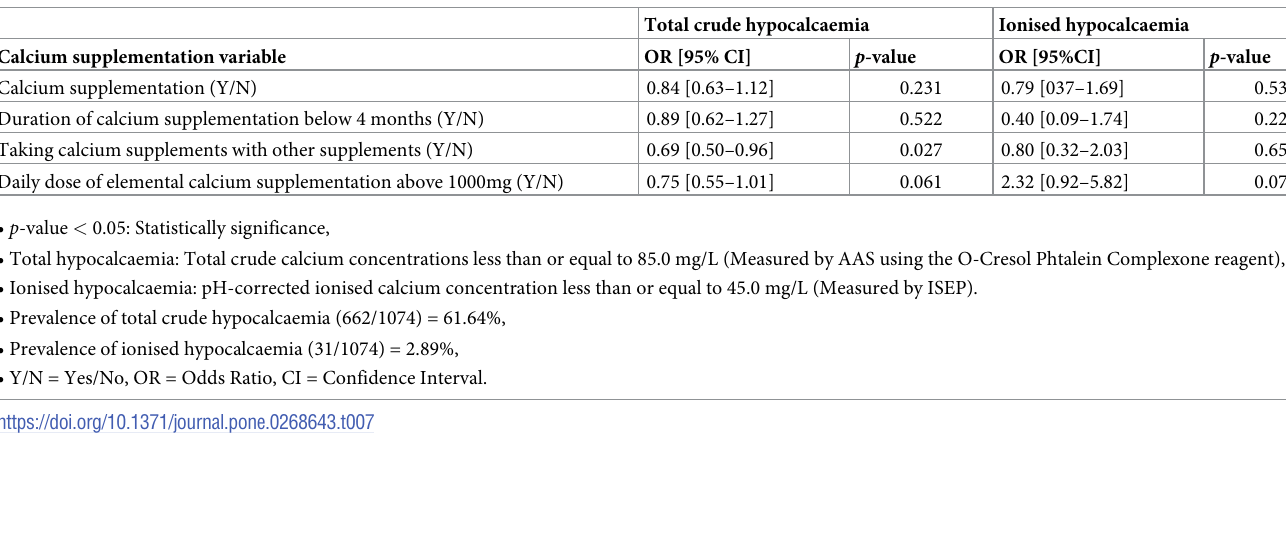
Table 7 evaluates calcium supplementation as a factor influencing calcaemic states. From the table, calcium supplemented women had respectively, 0.84 and 0.79 lower odds of total ( p -value = 0.231) and ionised hypocalcaemia ( p -value = 0.538) compared with non-supple- mented women. Also, taking calcium supplements at the same time as other supplements (iron and folic acid) significantly reduced the odds of total crude hypocalcaemia in pregnancy (OR = 0.69 [0.50–0.96], p -value = 0.027). Taking more than 1000mg of elemental calcium a day was associated with reduced odds of total crude hypocalcaemia (OR = 0.75 [0.55–1.01], p -value = 0.061). No statistically significant association was found between ionised hypocalcae- mia and calcium supplementation variables.